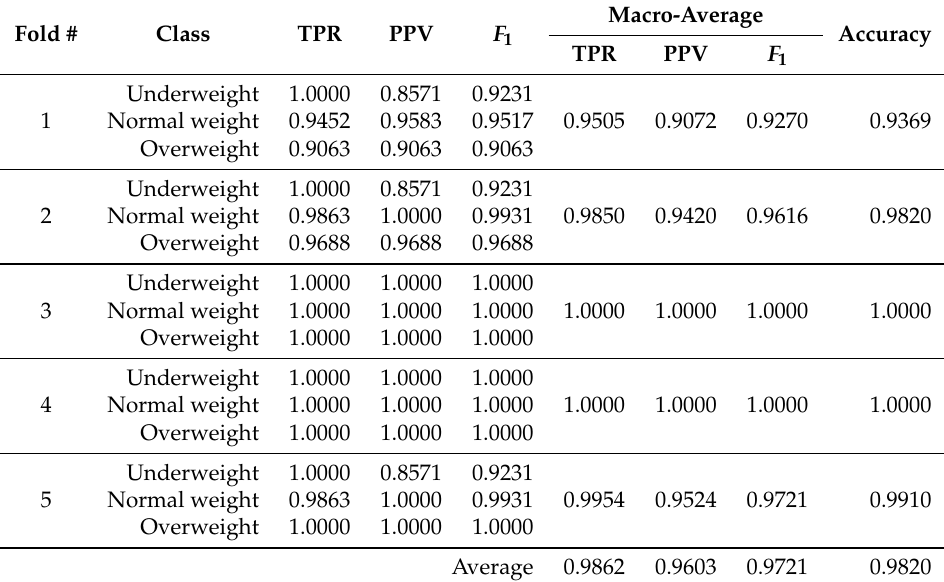
Table 8. Results of five-fold cross-validation for the proposed ensemble